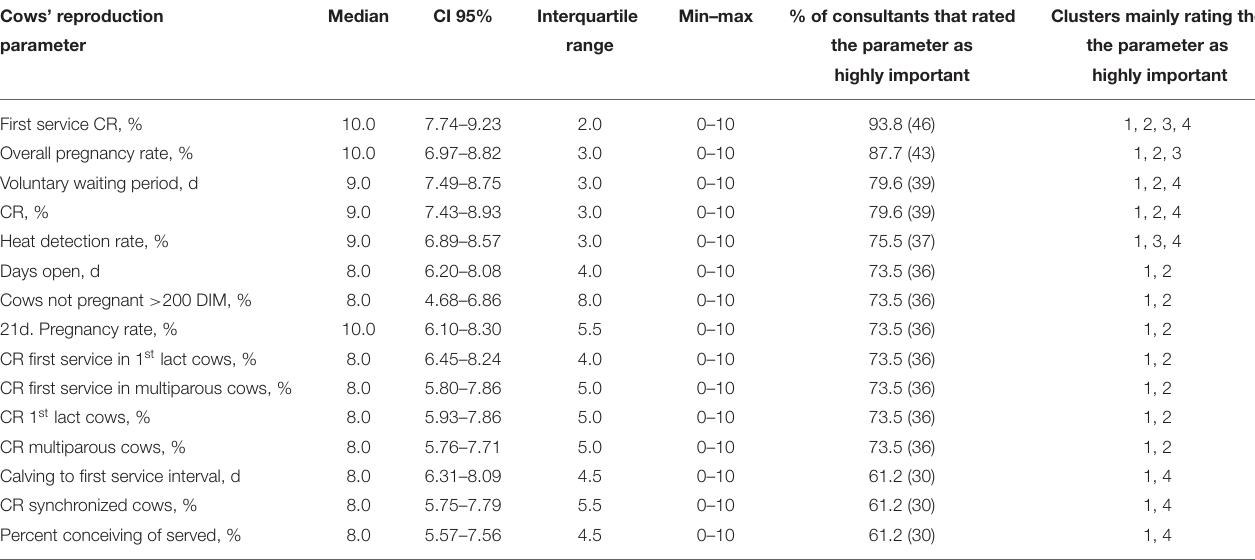
TABLE 4 | Parameters evaluated as highly important (range 8–10) on Section 3: Cows’ Reproduction used by, at least, 50% of the consultants surveyed after hierarchical clustering analysis. Cows’ reproduction Median CI 95% Interquartile Min–max % of consultants that rated Clusters mainly rating the parameter range the parameter as the parameter as highly important highly